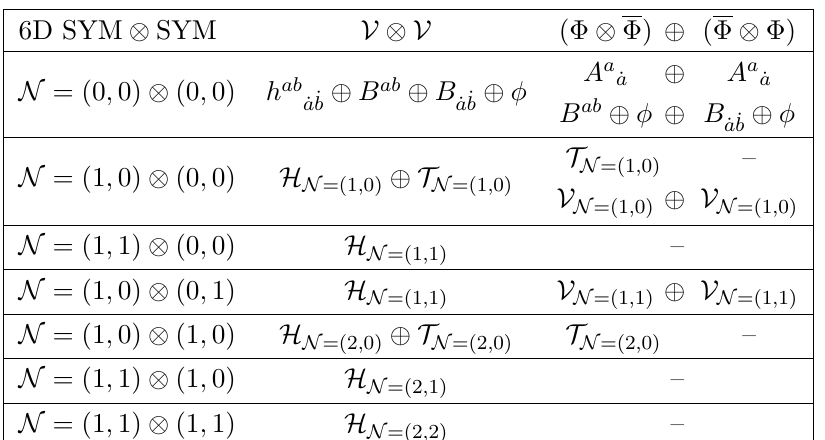
Table 1 . Summary of the double copy of on-shell vector and matter multiplets relevant for obtaining pure supergravities in six dimensions for various amounts of supersymmetry. The multiplets are: graviton H , tensor T , vector V , and hyper/chiral (cid:8). In the non-supersymmetric case there are two natural choices for the matter double copy, leading to either vectors or tensors and scalars; however, neither perfectly matches the matter content in the V (cid:10) V product. For the supersymmetric cases it is always possible to (cid:12)nd matching matter states in the V (cid:10) V and (cid:8) (cid:10) (cid:8) products, implying the latter can be used as ghosts. For the (1,0) and (2,0) supergravities, the matter double copy can be done using a half-hypermultiplet in a pseudo-real representation [9] (instead of fundamental); this gives a self-dual tensor multiplet.